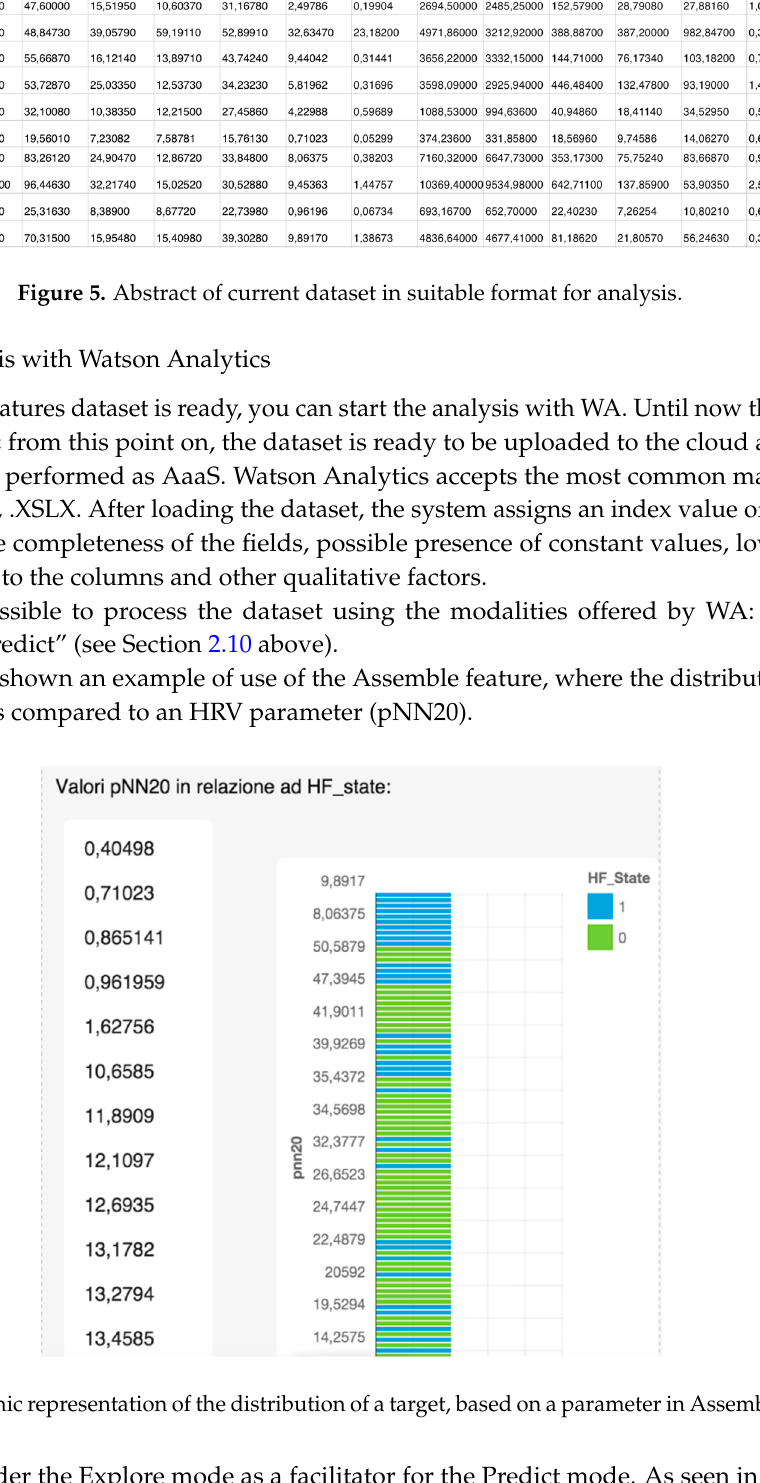
Figure 6 . Graphic representation of the distribution of a target, based on a parameter in Assemble mode.